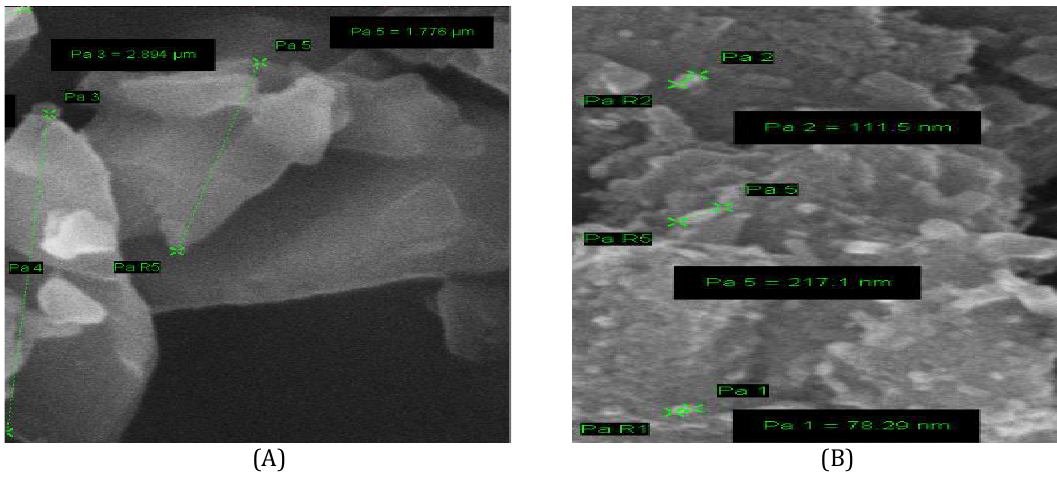
Figure 2. Curcumin morphology before and after pilling. (A) Curcumin morphology before pilling was in a size of > 1000 nm; (B) Curcumin morphology after pilling (nanocurcumin) in a size < 200